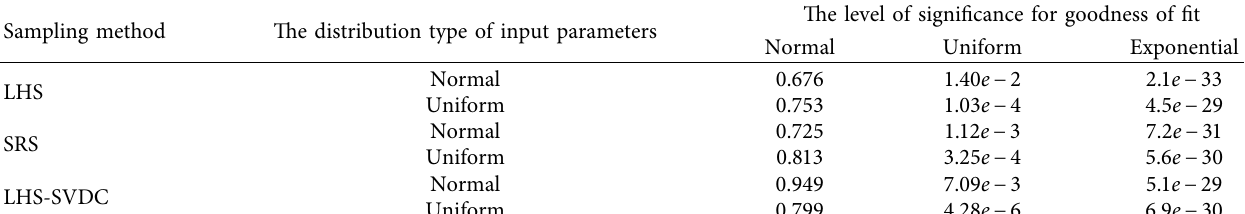
Table 6: K-S test results for the 100 calculated maximum fuel